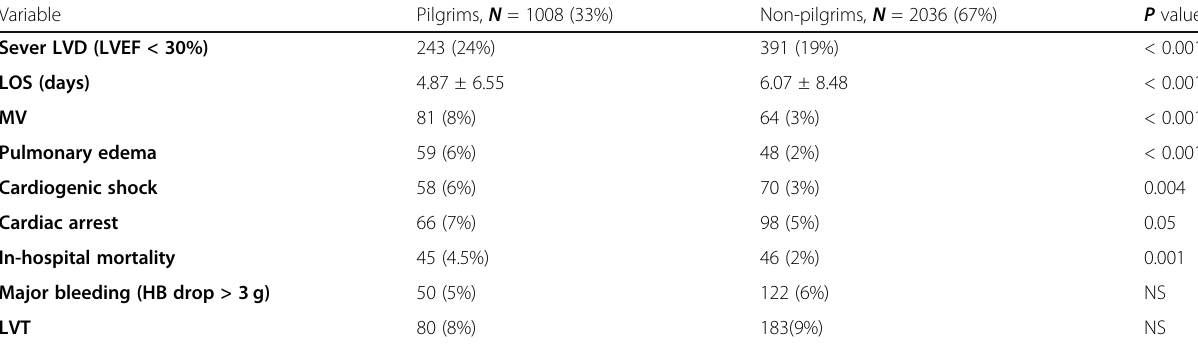
Table 3 Hospital outcome data of pilgrim and non-pilgrim AMI patients Variable Pilgrims, N = 1008 (33%)